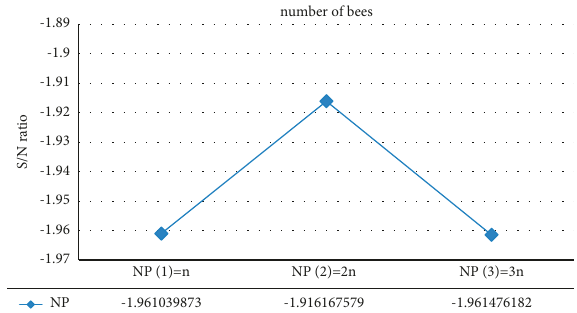
Figure 2: Graph of average S / N ratio for each level of NP factor of ABC algorithm in model solving.